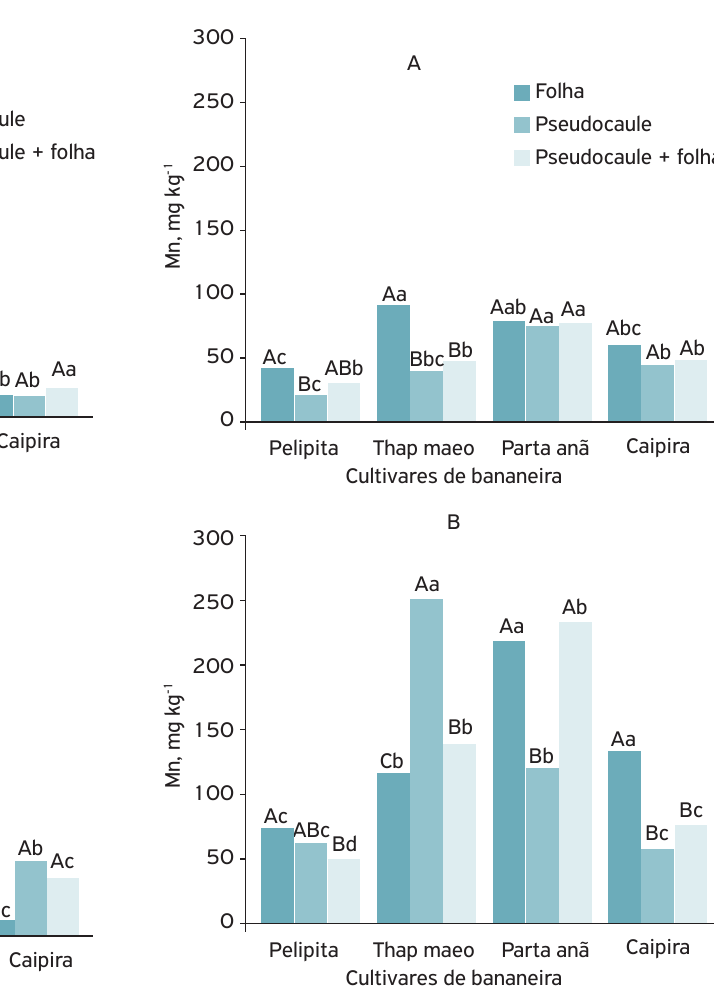
Figura 3. Teores de Fe, mg kg -1 , presente no substrato à base de resíduos de bananeira (pseudocaule, folha e pseudocaule + folha) de quatro cultivares de bananeira (Thap maeo, Prata anã, Pelipita e Caipira) antes (A) e após 49 dias (B) de colonização pela linhagem 09/100 de Pleurotus ostreatus . Letras maiúsculas comparam minúsculas comparam médias dentro de cada tipo de resíduo.